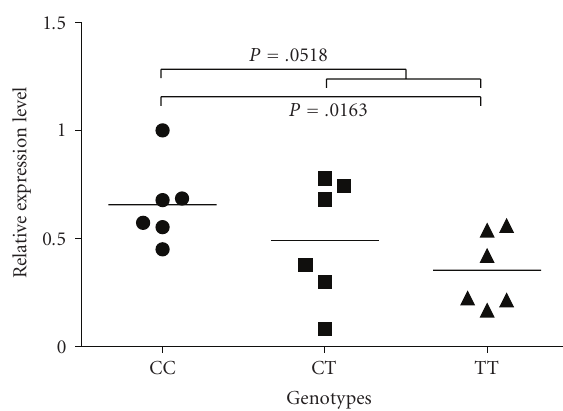
Figure 1: Quantification of MTIF3 mRNA levels. MTIF3 mRNA levels in Epstein-Barr virus (EBV) transfected B-lymphocytes from individuals carrying the three di ff erent rs7669 genotypes, normalized to the housekeeping genes beta-actin and cyclophilin. mRNA levels were found to be significantly lower in TT genotypes compared to CC genotypes ( P = . 0163) using Student’s t